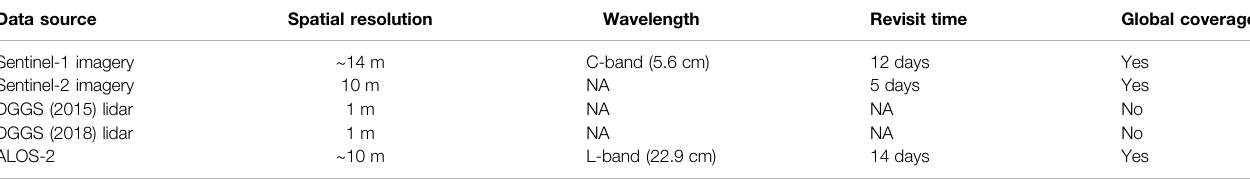
TABLE 1 | The spatial resolution, wavelength, revisit time, and coverage offered by the sensors whose data were used in this